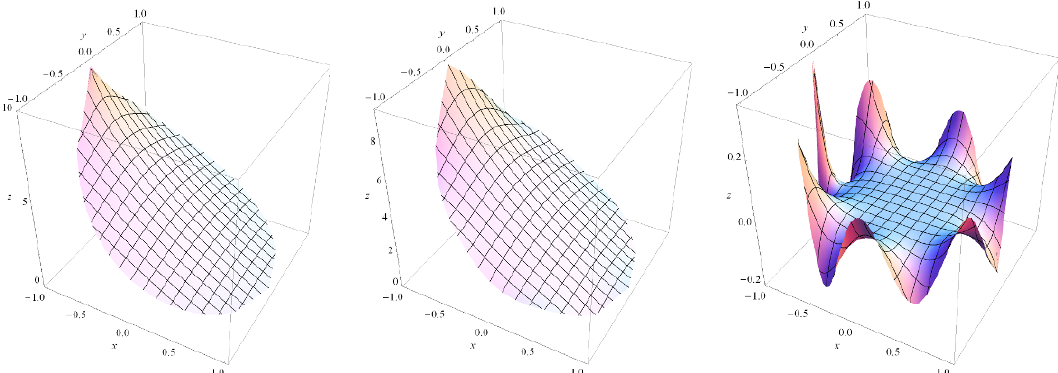
Figure 8. Third example, n = ‘ = 6 : function u , interpolant p , error u −